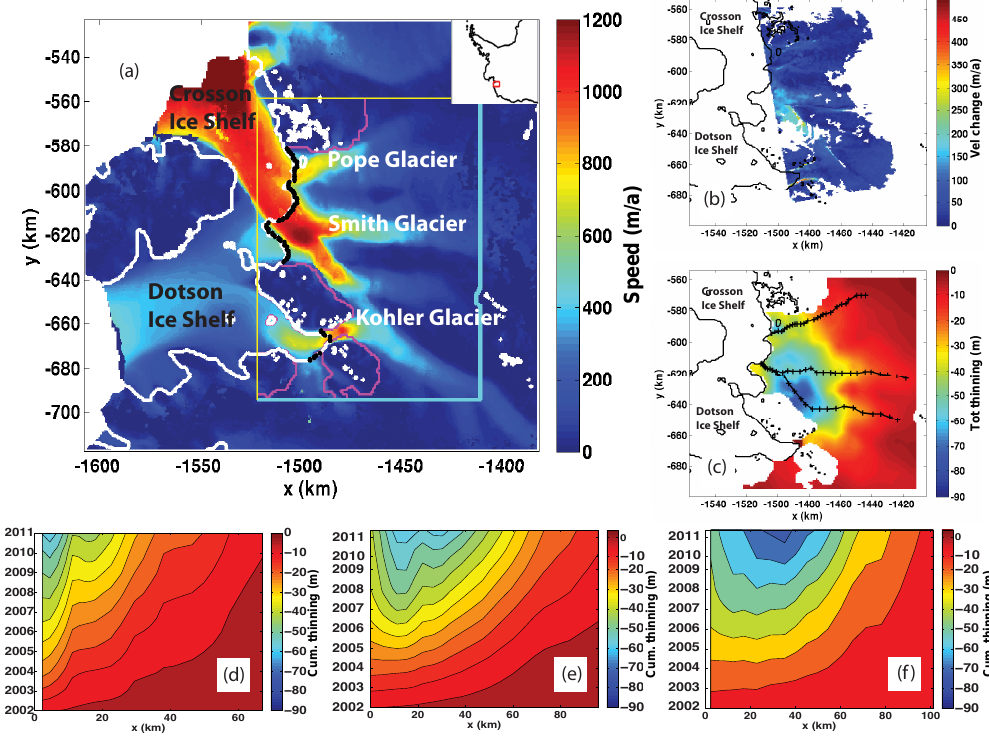
Figure 1. (a) Ice speed in the Pope/Smith/Kohler and Crosson/Dotson system. The white contour is the grounding line as given by BEDMAP2, and the magenta contour represents the limits of the transient surface elevation data set. The rectangular box shows the subdo- main used for our state estimate simulations – boundary stresses are imposed along the black contour and boundary fluxes are imposed along the light blue boundaries. (b) Norm of velocity change between 2006 and 2010 within the model domain, excluding the areas of no coverage in either 2006 or 2010. (c) Cumulative surface thinning, 2001–2011 in the surface elevation data set. The shaded region shows where data are available. (d, e, f) Hövmoller plots of cumulative thinning along transects in (c) in descending